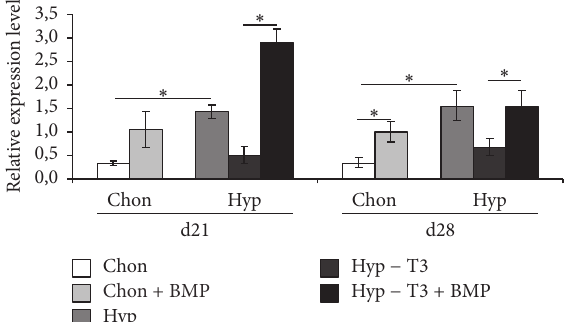
Figure 6: Gene expression analysis of BAMBI normalized to HPRT in MSC pellet cultures after BMP4 treatment under chondrogenic (chon) and hypertrophy (hyp) enhancing conditions analysed by real-time PCR. BAMBI expression is increased under chondrogenic and hypertrophic conditions after BMP4 treatment. 𝑛 = 4 different donors, ∗ 𝑝 < 0.05 .